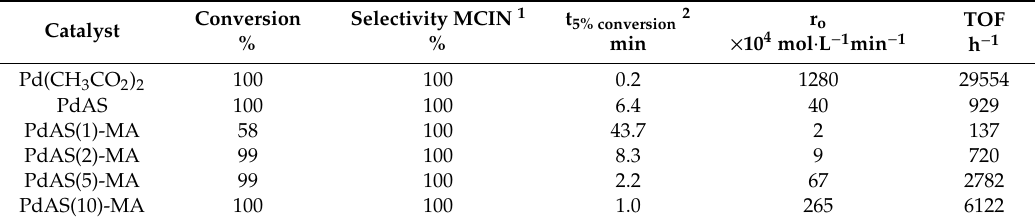
Table 3. I-Ph conversion, time to reach a conversion level of 5%, initial reaction rate (ro) and turnover frequency (TOF) for Pd-based